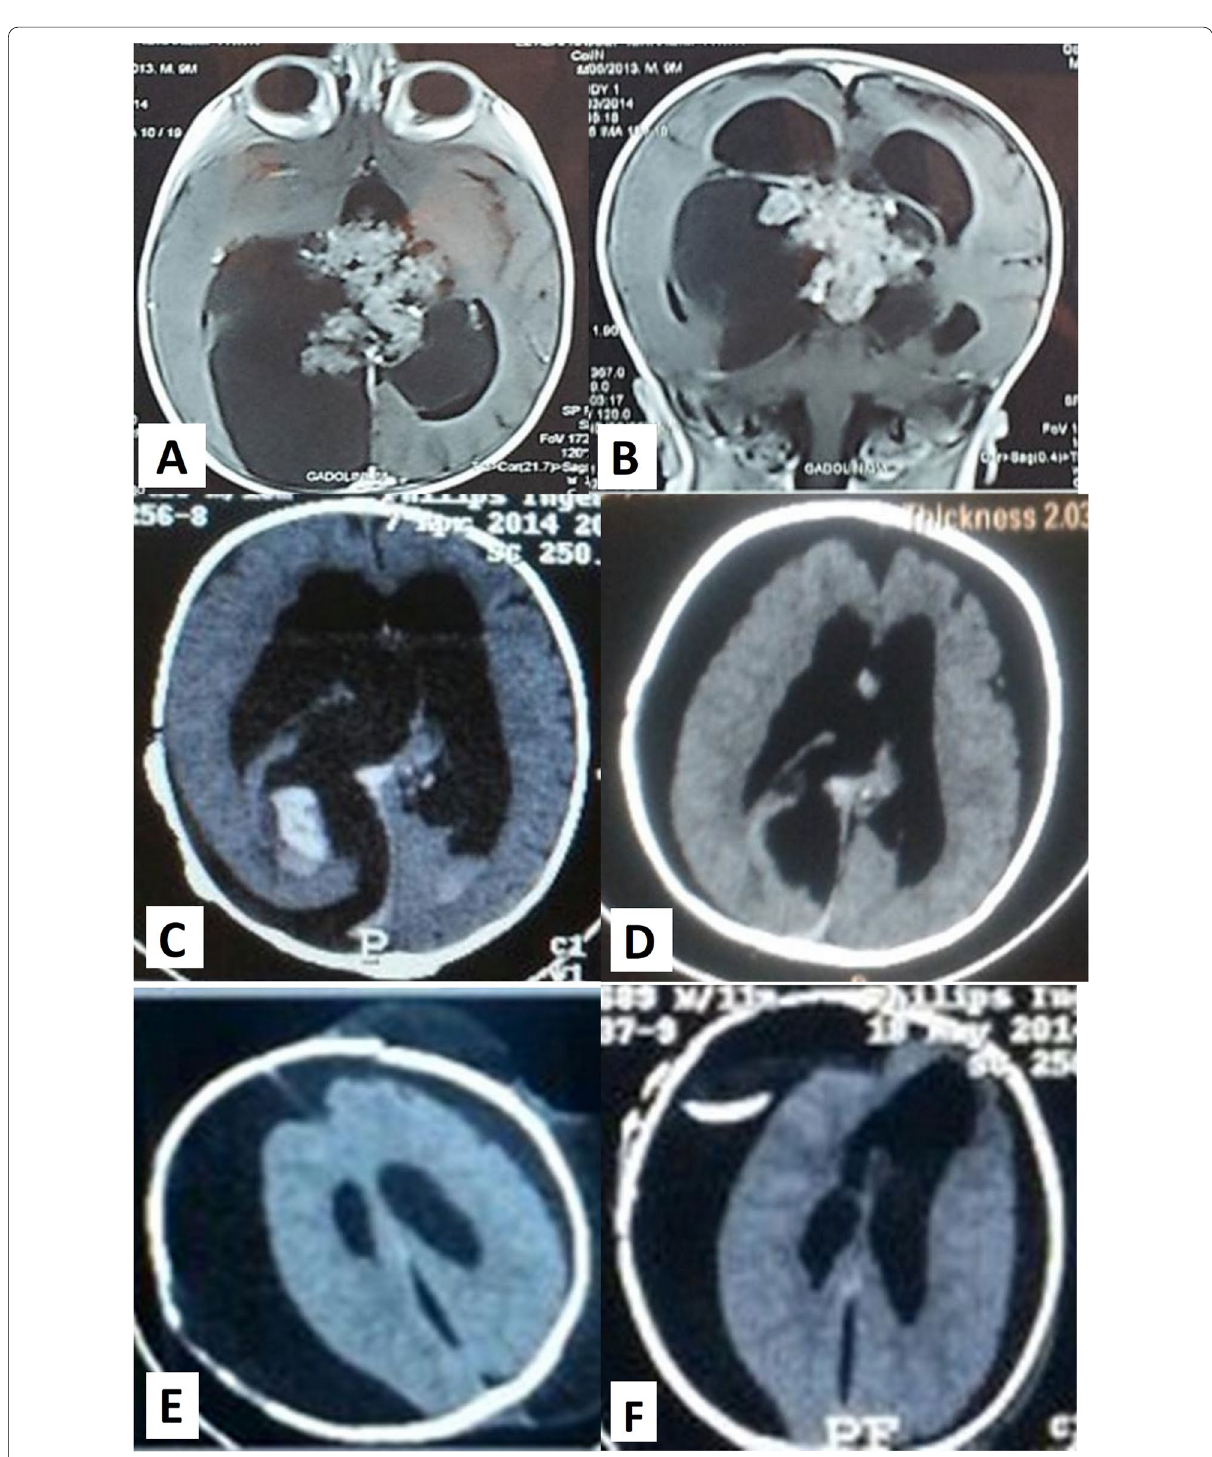
Fig. 2 a, b Contrast enhanced MRI brain T1 films (axial and coronal views) showing huge choroid plexus carcinoma with developing hydrocephalus. c Immediate postoperative CT brain reveals a well removed intraventricular tumor with minimal right subdural collection. d , e Seven days postoperative CT brain reveals increasing of the subdural collection bilaterally and more on the right side. We can notice a vanishing of the right sulci and gyri of the right hemisphere. f Postoperative CT brain after insertion of the subdural-peritoneal